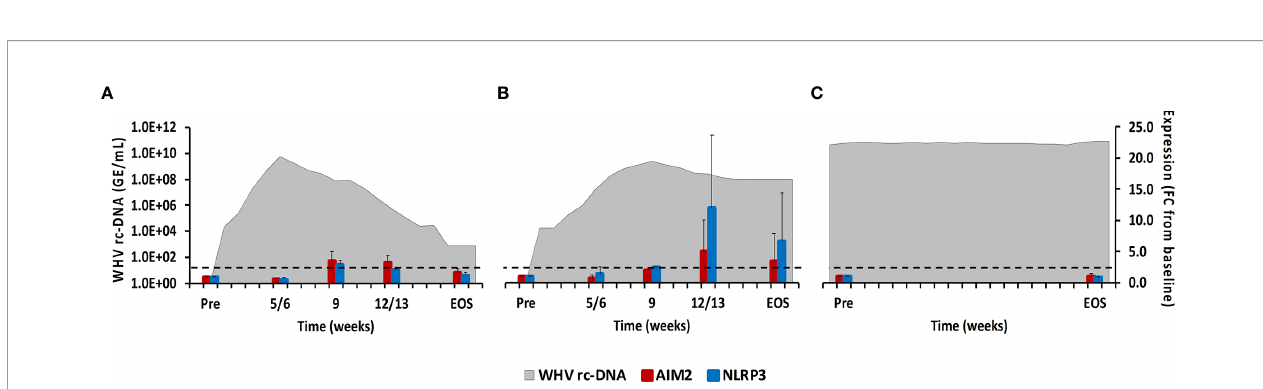
FIGURE 7 | Intrahepatic in fl ammasome expression. Expression changes of AIM2 and NLRP3 in liver with WHV rc-DNA kinetics of woodchucks during (A) AHB with normal resolution (n=5), (B) AHB with delayed resolution (n=5), and (C) CHB progression (n=3). The fold-changes in receptor transcript level are plotted on the right y-axis, while serum WHV rc-DNA loads are plotted on the left y-axis. The horizontal, dotted line indicates the cutoff for positive expression (i.e., ≥ 2.1-fold increase from the pre-inoculation baseline). Horizontal bars represent the standard error of the mean. Pre, pre-inoculation for AHB and start of study for CHB; EOS, end of study; FC,